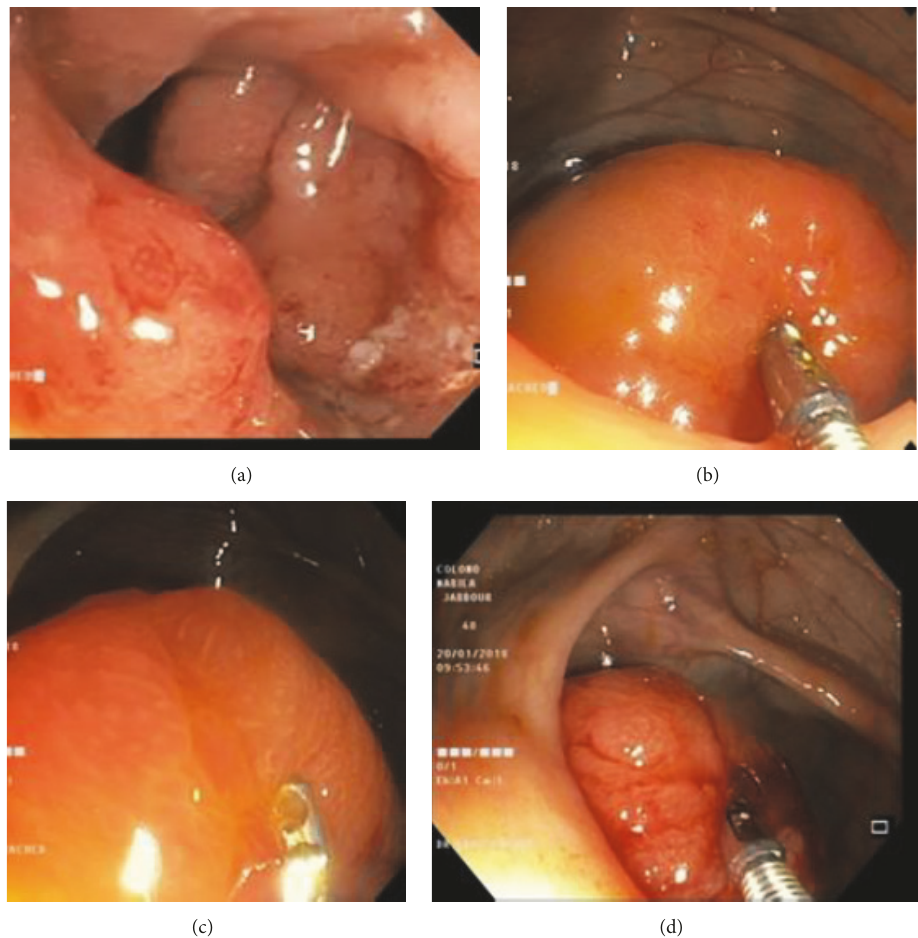
Figure 1: (a) Hyperaemia and diffuse superficial ulcerations of left colon. (b), (c), and (d) The giant pseudopolyp in the cecum with a normal colonic